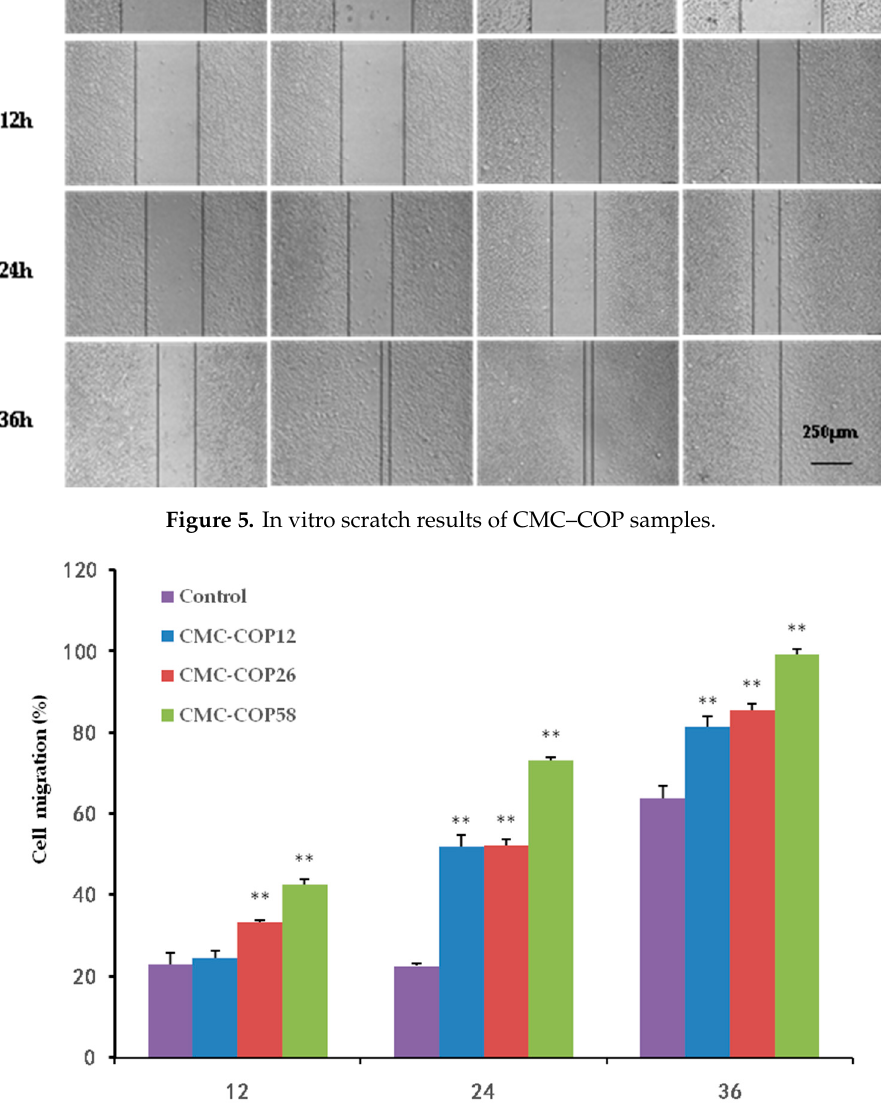
Figure 6. Effect of CMC – COP samples on the L929 cell migration rate ( n = 6). ** p < 0.01.